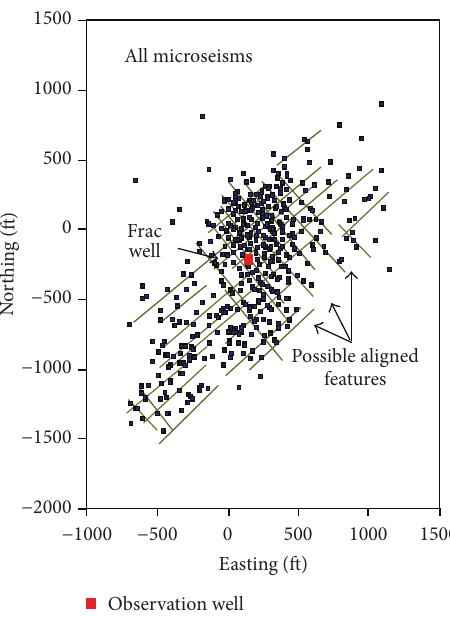
Figure1:Microseismicmappingconfirmedcomplexfractureexten- sion in shale reservoirs [21].